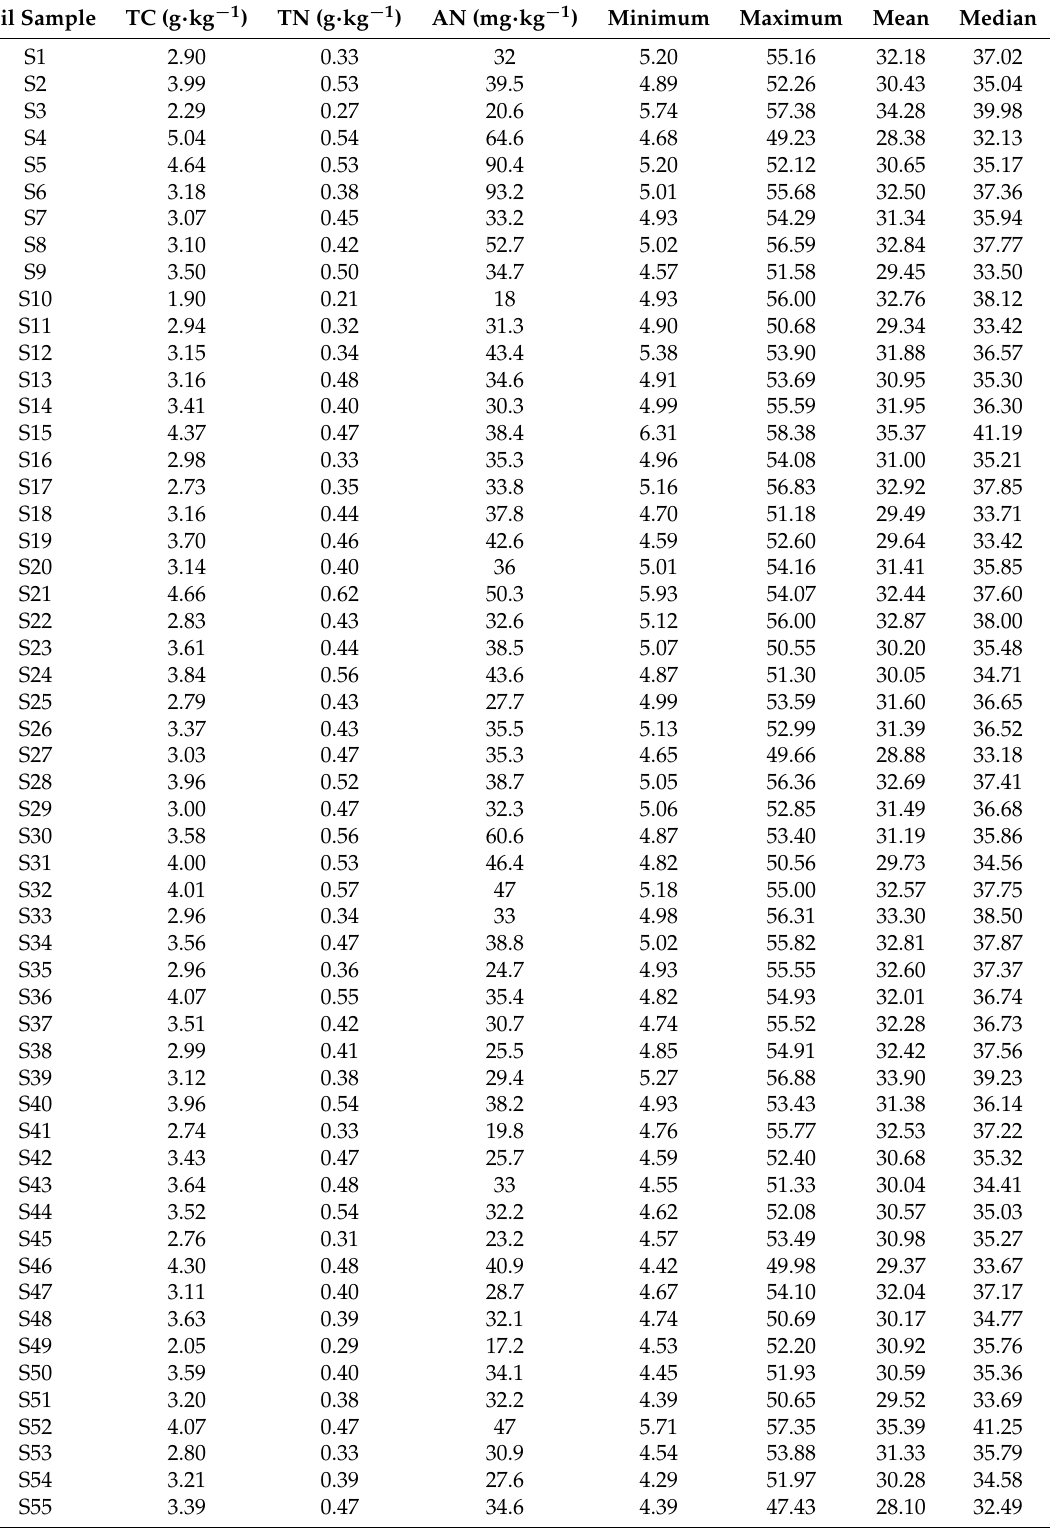
Table A1. Basic information on samples from S1 to